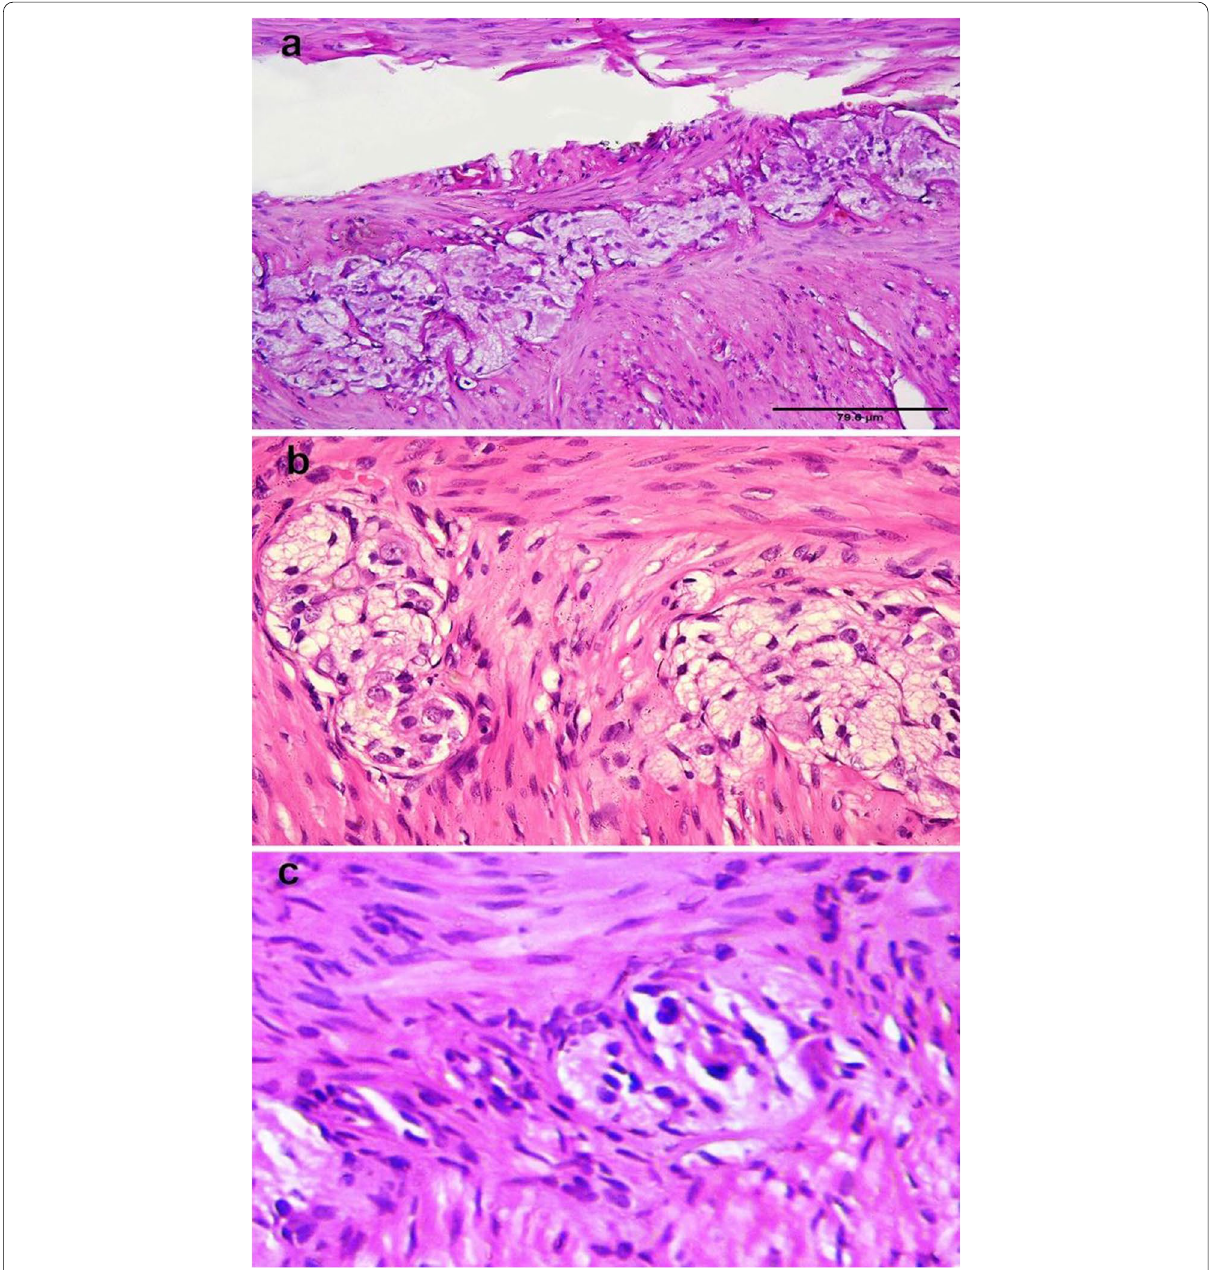
Fig. 1 Intestinal segments with different numbers of ganglion cells: hyperganglionic segment with giant ganglia displaying > 10 ganglion cells (H&E, 200) ( a ). An adequately ganglionic specimen in a case of clinically queried Hirschsprung’s Disease (H&E, × hypoganglionosis with degenerated ganglion cells